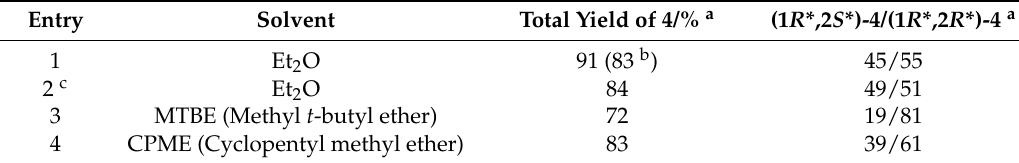
Molecules 2019 , 24 , 1023 Table 1. Stereoselectivity of the ring-closing reaction leading to racemic cyclopropane nitriles 4 .